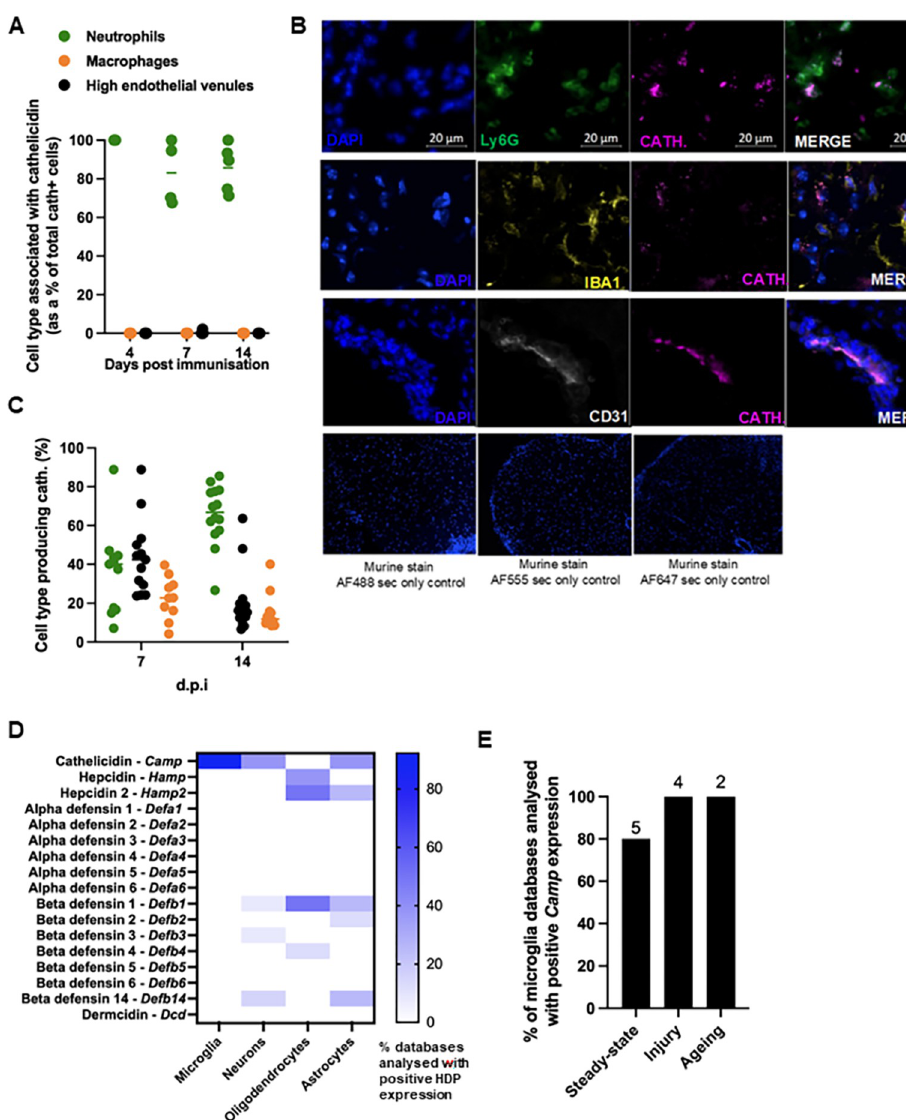
Fig 2. Cathelicidin is produced by multiple cell types in the CNS during EAE. EAE was induced in WT C57BL/6J mice on day 0 and mice observed for 28 days. Throughout the experiment, mice were humanely culled, perfused with 4% paraformaldehyde and cathelicidin-producing cells were quantified. On days 7 and 14 post-immunisation, co- staining was performed to determine production of cathelicidin by Ly6G+ neutrophils, F480 + /Iba1 + microglia/ macrophages, and CD31 + endothelial cells. (A) Shows the cell type associated with cathelicidin in the draining inguinal lymph node. (B) Example images from spinal cord on day 14 and contribution of each cell type to overall cathelicidin production in the (C) spinal cord was determined on day 14 post-immunisation. Analysis of published sequencing databases of murine microglia, astrocytes, oligodendrocytes, and neurons were performed. Databases were either accessed from supplementary information of the relevant papers or searched for in NCBI GEO Datasets. The search terms were as follows: “cell type” AND “rna seq” AND “mouse” NOT “iPSC.” (D) All datasets during steady state were analysed for expression of HDPs. The heatmap shows the percentage of databases analysed that expressed the named HDP. Blue indicates a high percentage of databases had positive expression, and white indicates a low percentage of databases had positive HDP expression. (E) The percentage of microglia databases analysed that had positive Camp expression in different conditions—steady-state, injury, and ageing. The number above the bar represents the number of databases analysed. Data shown are individual data points with line at median. N values: A– 3–5 sections from 3 mice; B and C– 13–18 sections from 4 mice; D–microglia– 13, neurons– 16, oligodendrocytes– 8, and astrocytes– 8; E– steady state– 5, injury– 4, ageing– 2. (Dataset information listed in S1 and S2 Tables). Data available at 10.6084/m9. figshare.20310363. Cath, cathelicidin; CNS, central nervous system; dpi, days post immunisation; EAE, experimental autoimmune encephalomyelitis; HDP, host-defence peptide; sec, secondary; WT, wild-type.